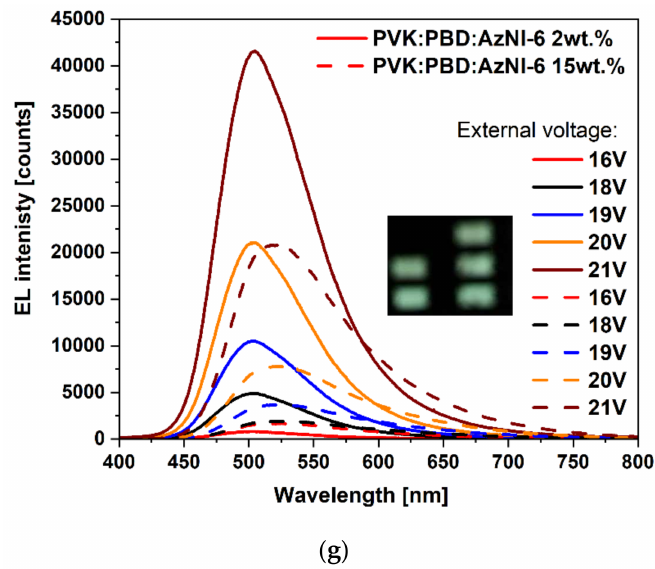
Figure 7. ( a ) HOMO and LUMO energy levels with work function of ITO and Al, ( b – g ) electrolumi- nescence spectra’s of the tested diodes (insert: photos of the working